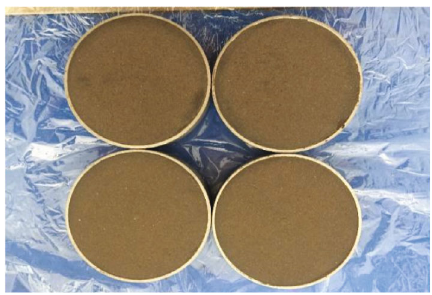
Figure 3: Soil samples of the test.